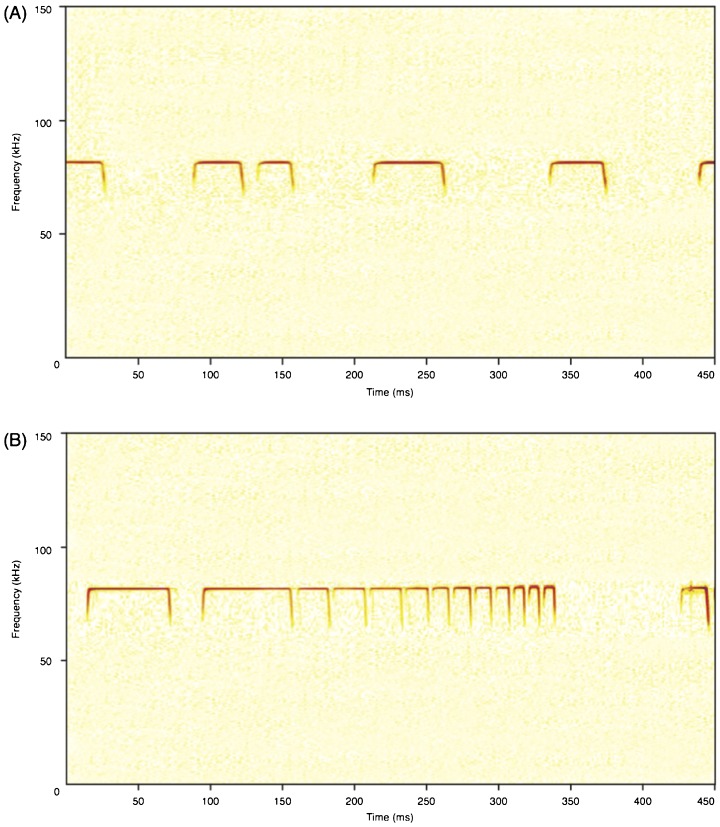
Echolocation call sequences of R. capensis during flight in this study.Calls emitted were of high duty cycle, and contained the characteristic long central CF call component, initiated by an upward FM sweep, FMi, and terminated by a downward FM sweep, FMt. (A) R. capensis flying alone in the large flight room. (B) R. capensis capture sequence as it attacks a moth when flying alone in the small flight room.